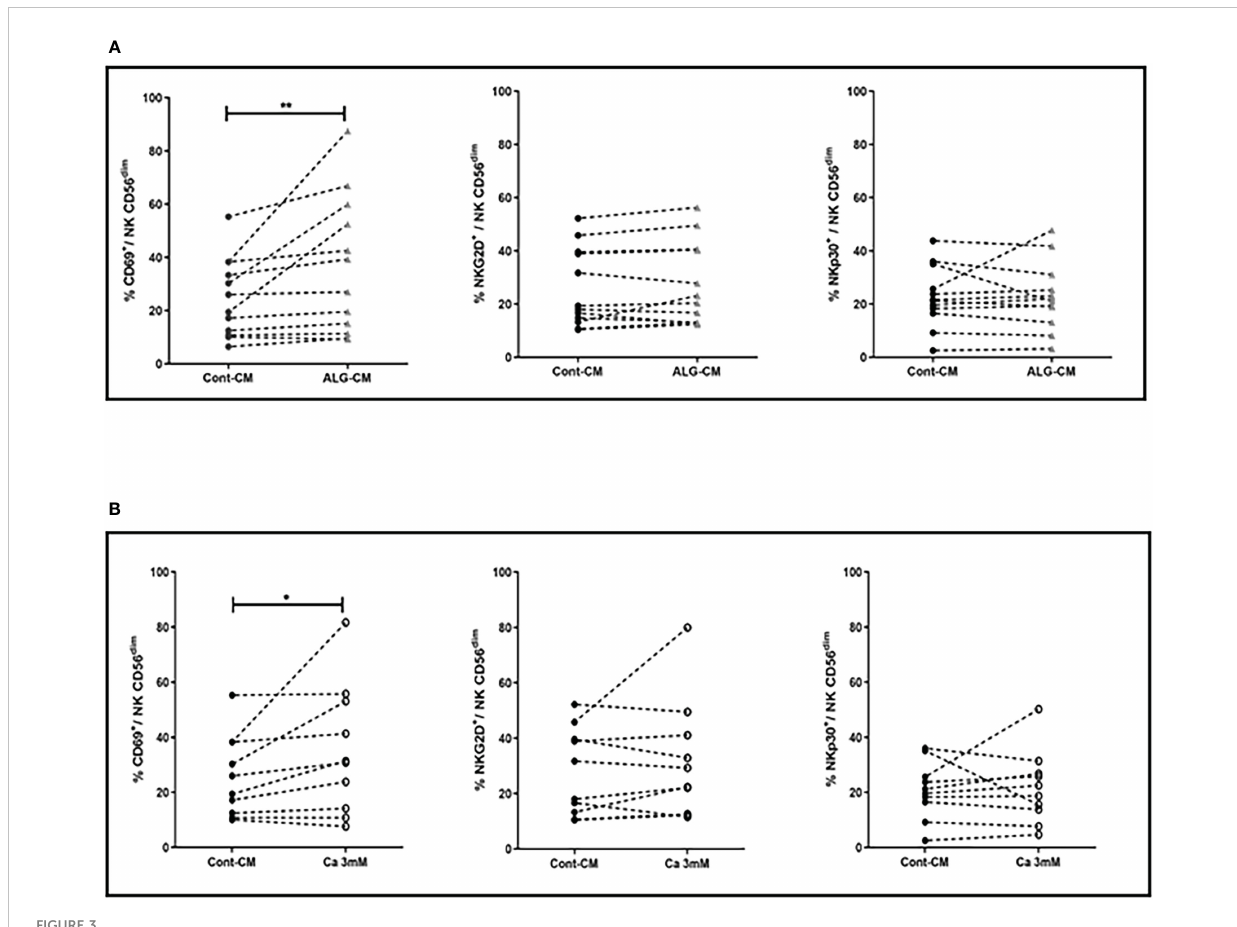
FIGURE 3 Activating receptor expression on NK cells. Expression levels of NK cell activating receptors: CD69 (left side), NKG2D (middle), and NKp30 (right side) were studied on NK CD56 dim after cell incubation for 18h with: (A) CaCl 2 solution at 3mM (white circle), (B) ALG-CM (grey triangle). Each line links data from the same donor (A: n=10) and (B: n=12). Statistical comparison of data versus control expression (dark circle) was assessed using Wilcoxon paired test * p <0.05, ** p